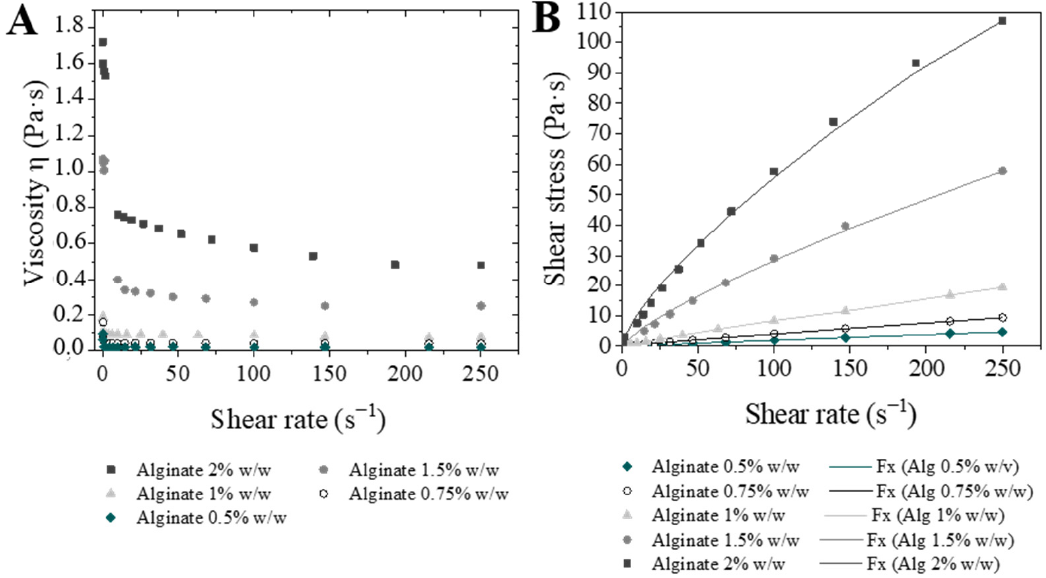
Figure 2. Representation of rheological results: ( A ) Viscosity vs. γ (Shear rate); ( B ) τ (Shear stress) vs. γ (Shear rate).